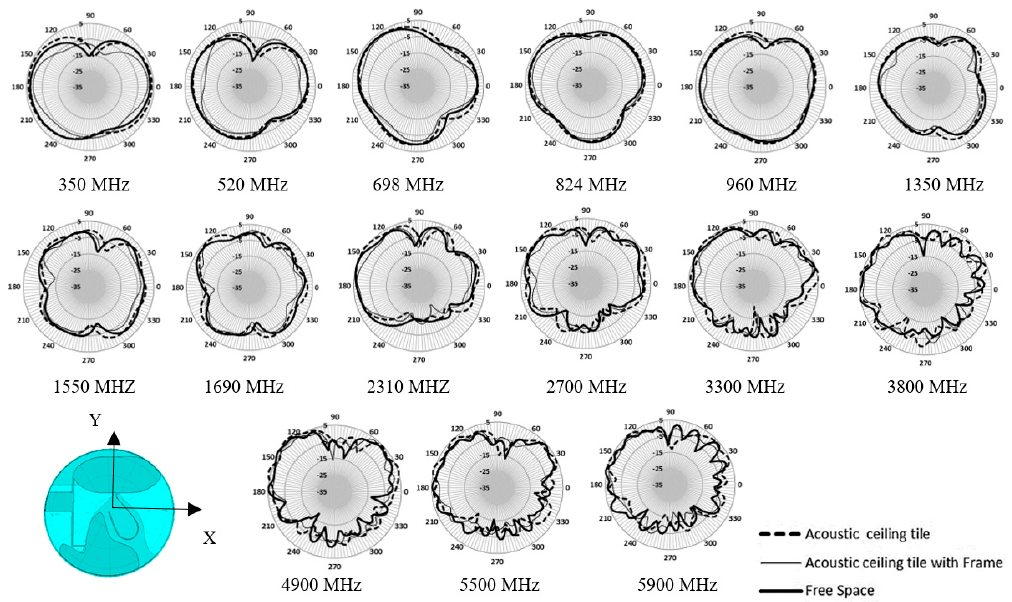
Figure 32. Ceiling tiles and frame effect to the antenna measured azimuth plane (X-Y plane) radiation pattern.